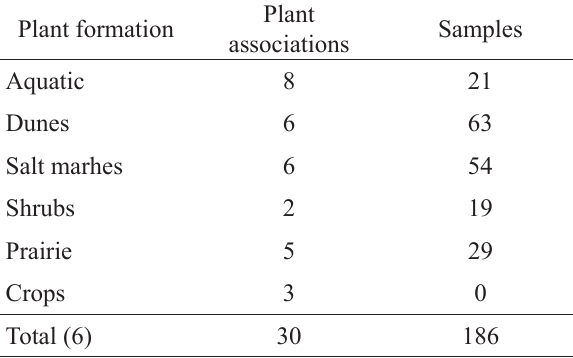
Table1. Number of plant associations and number of vegetation samples raised for each plant formation studied in the work place.